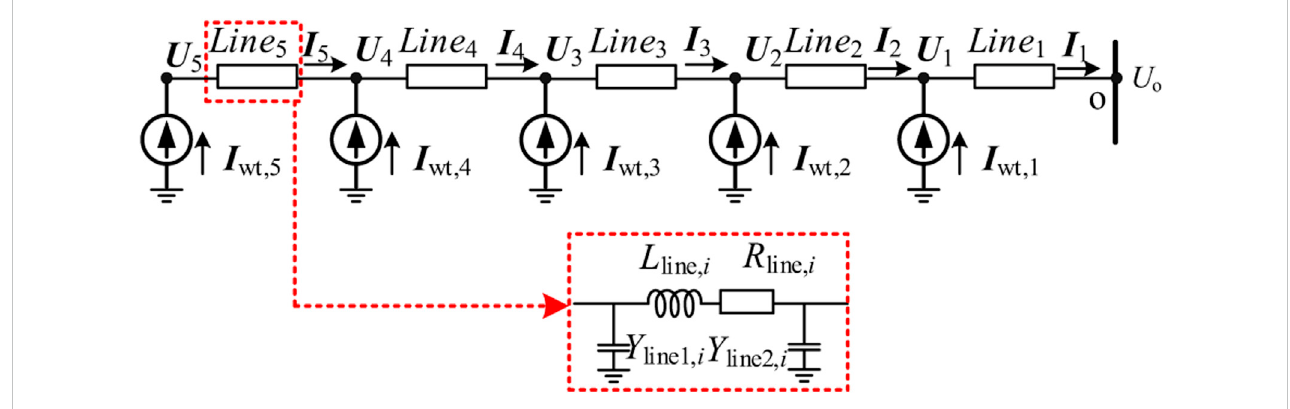
FIGURE 4 Equivalent circuit of a feeder in the OWF.